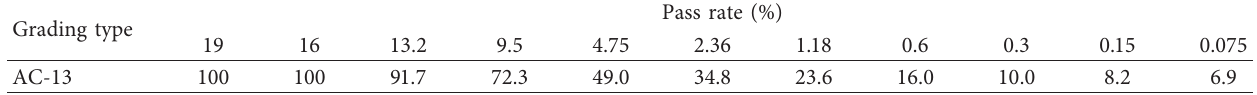
Table 6: Synthetic grading of mineral aggregate.